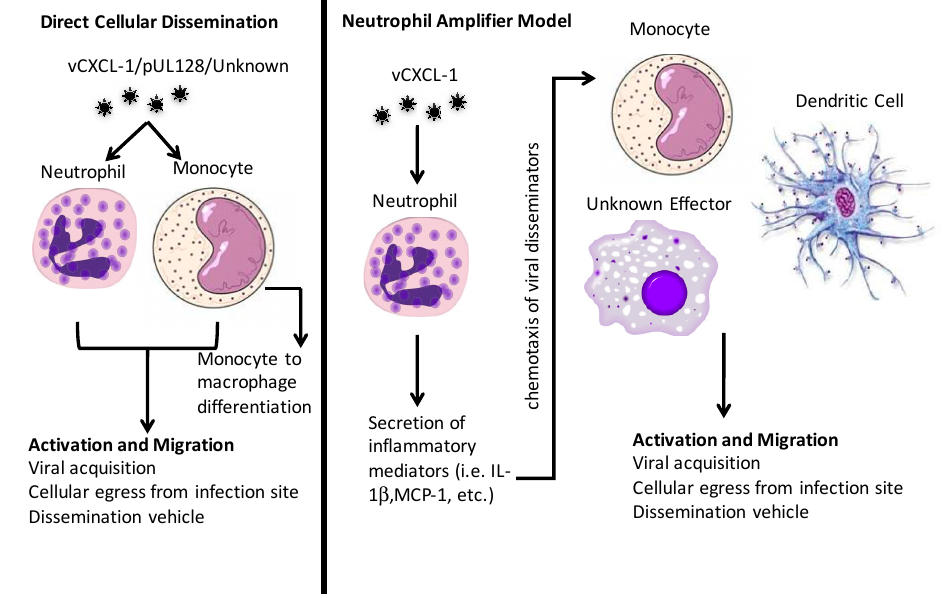
Figure 2. Graphical representation of direct cellular dissemination and the neutrophil amplifier model.